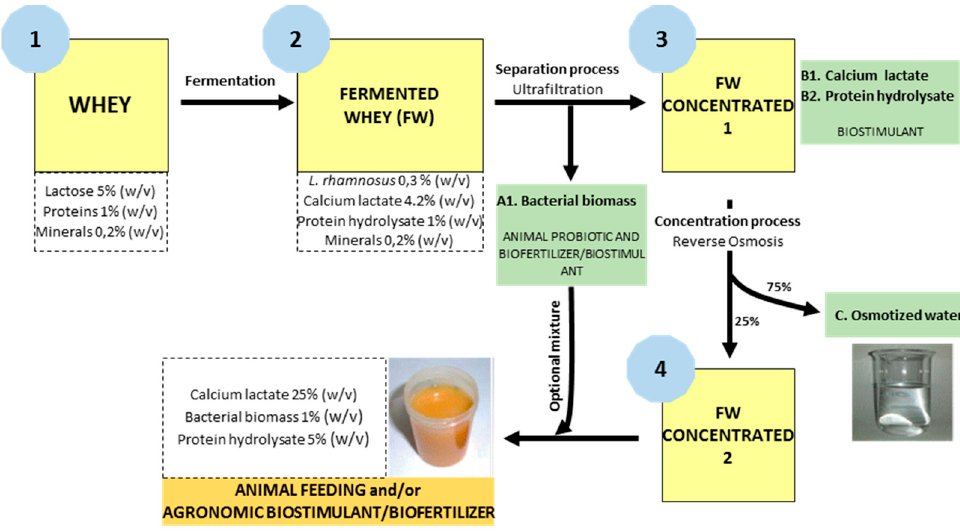
Figure 3. Scheme of the whey treatment process. Detailed steps are shown as well as each valuable fraction obtained.